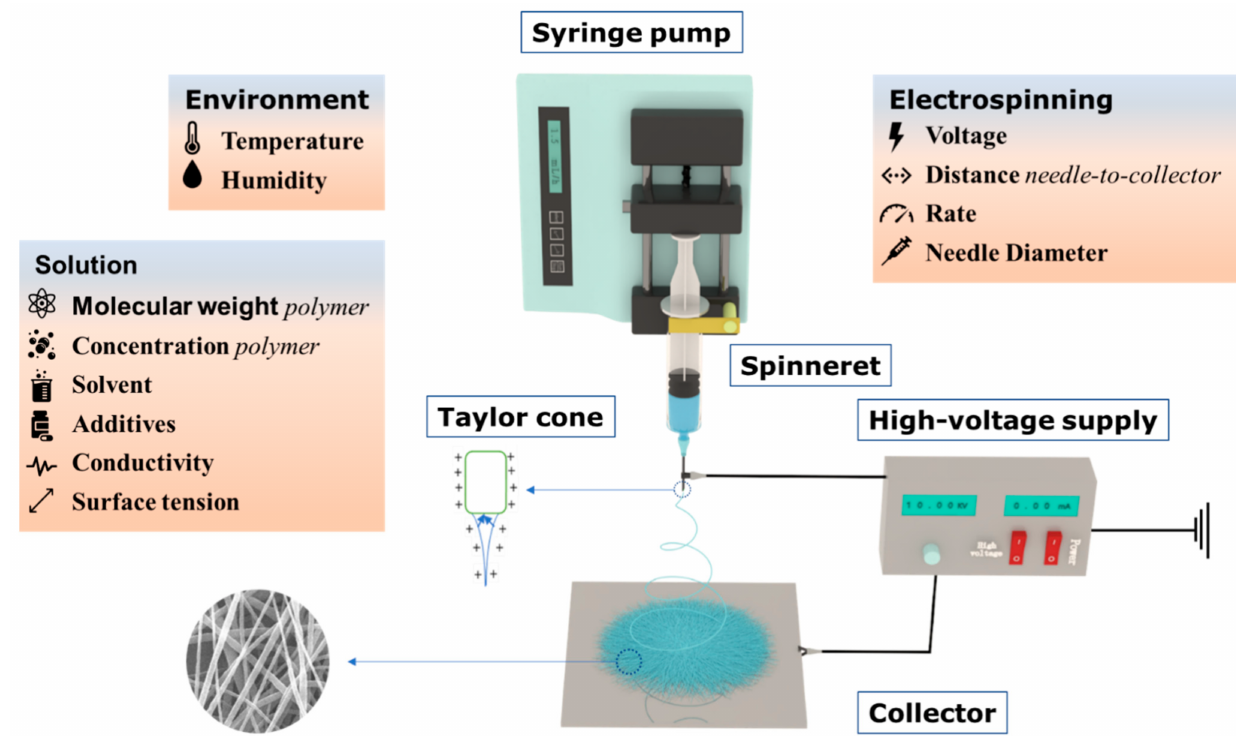
Figure 2. Electrospinning schematic diagram and influencing